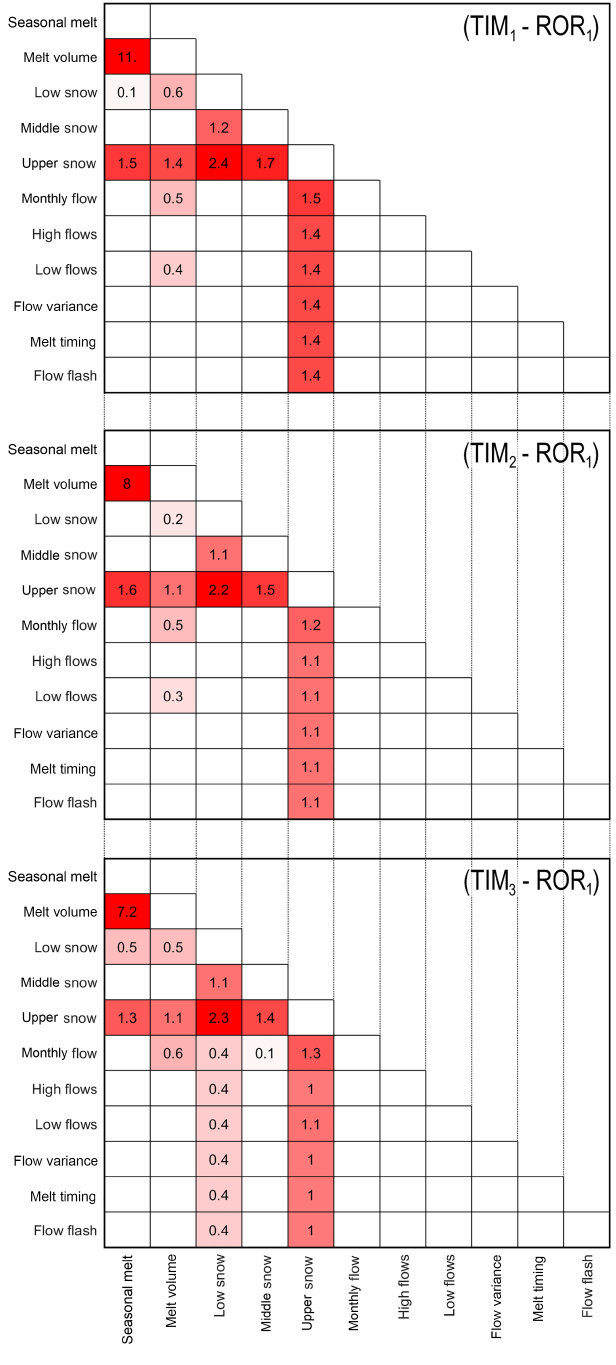
Figure 17. Average consistency scores between attributes using the three melt model structures in combination with the ROR 1 run-off- routing structure. Scores of < 0.1 have not been